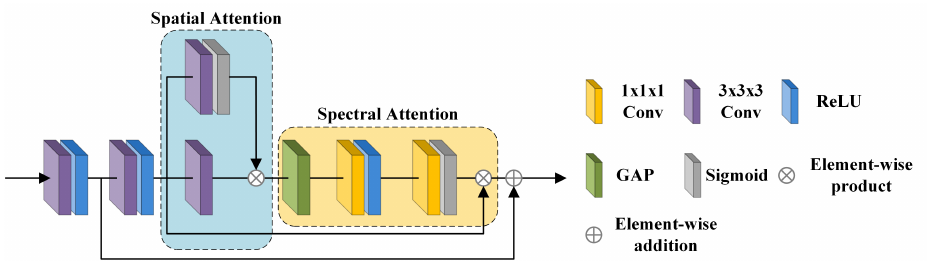
Figure 4. An illustration of the SSCA block, which mainly includes two attentions, i.e., spatial attention (SA) in blue area and spectral attention in yellow area. For the latter spectral attention, we build three versions (see more details from Figure 5) and finally select the SCA with the best performance as the